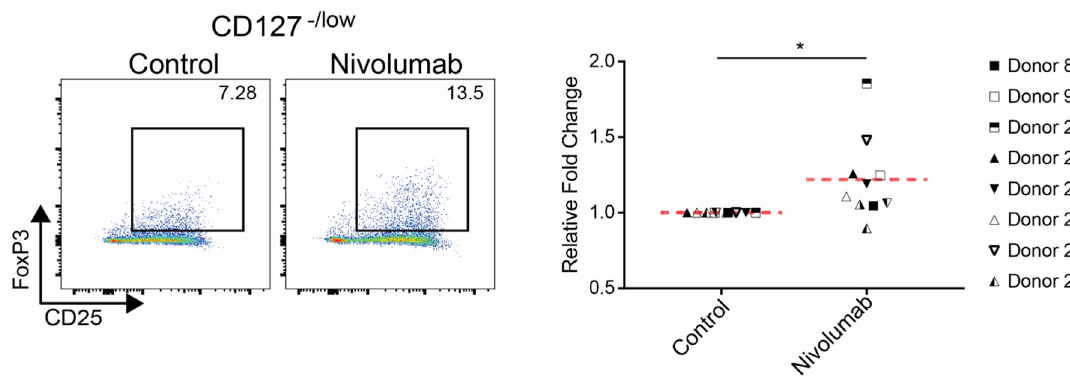
Figure 6. Nivolumab treatment induces the expansion of regulatory T cells. Frozen PBMCs were thawed and cultured in RPMI1640 medium containing 5% AB human serum. Cells were treated with Nivolumab (20 μ g/mL) in the presence of anti-CD3 mAb (0.1 μ g/mL) for three days and were subsequently harvested for flow cytometric analysis of the expression of regulatory T cell markers CD25 and FoxP3 gated on CD4 + CD127 -/low T cells. The left panels show the data from one representative donor’s PBMCs, whereas the right panel provides a summary of data from eight different individual donors. * p < 0.05.